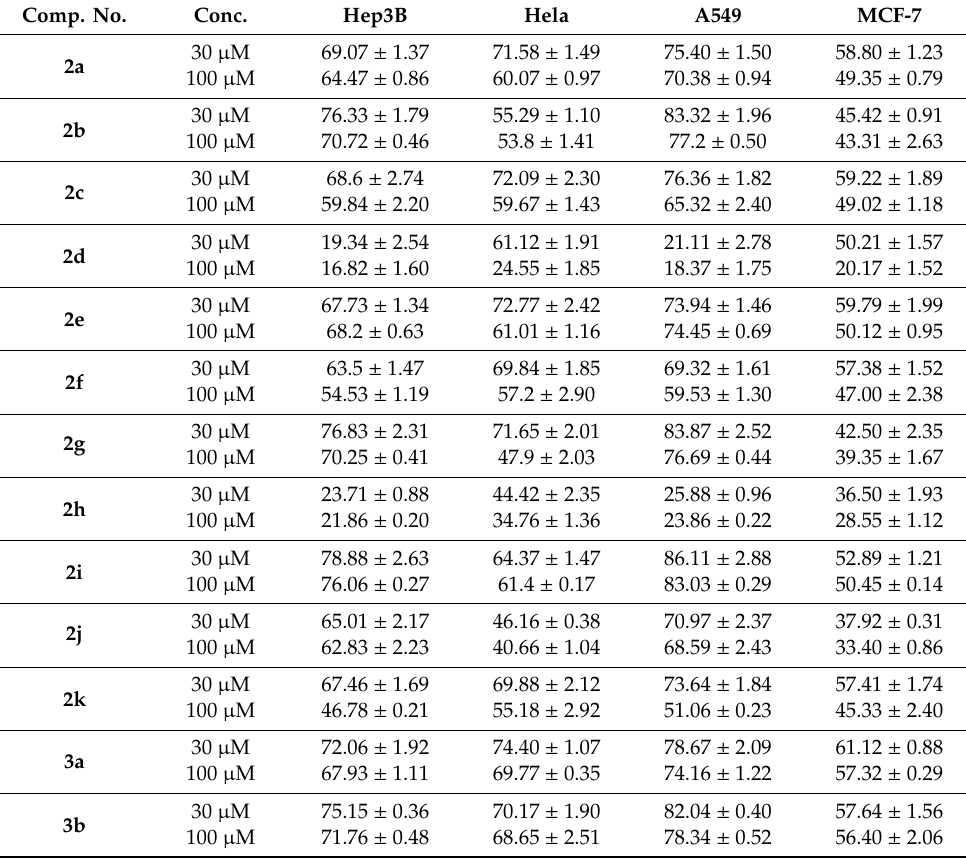
Table 4. The e ff ect of synthesized thiosemicarbazones 2a – k and 3a – j on the viability of Hep3B, Hela, A549, and MCF-7 cells after 48 h of incubation. Comp.